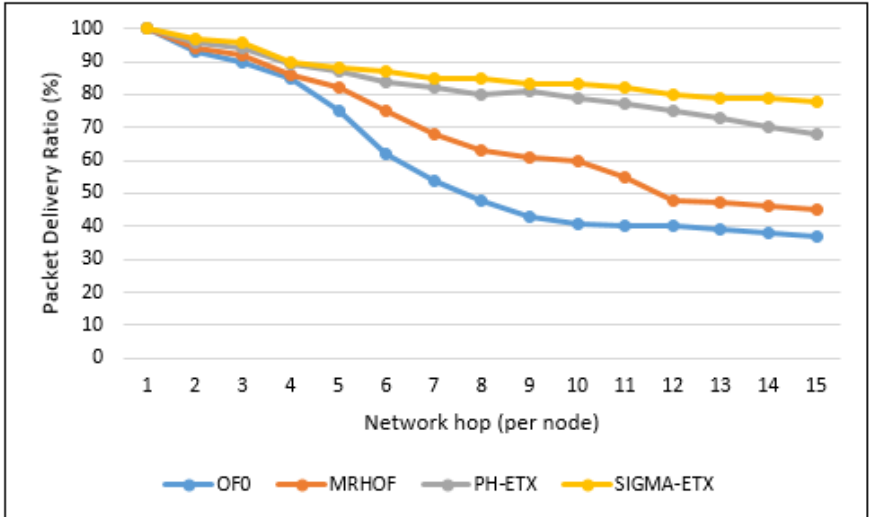
Figure 13. Packet delivery ratio.